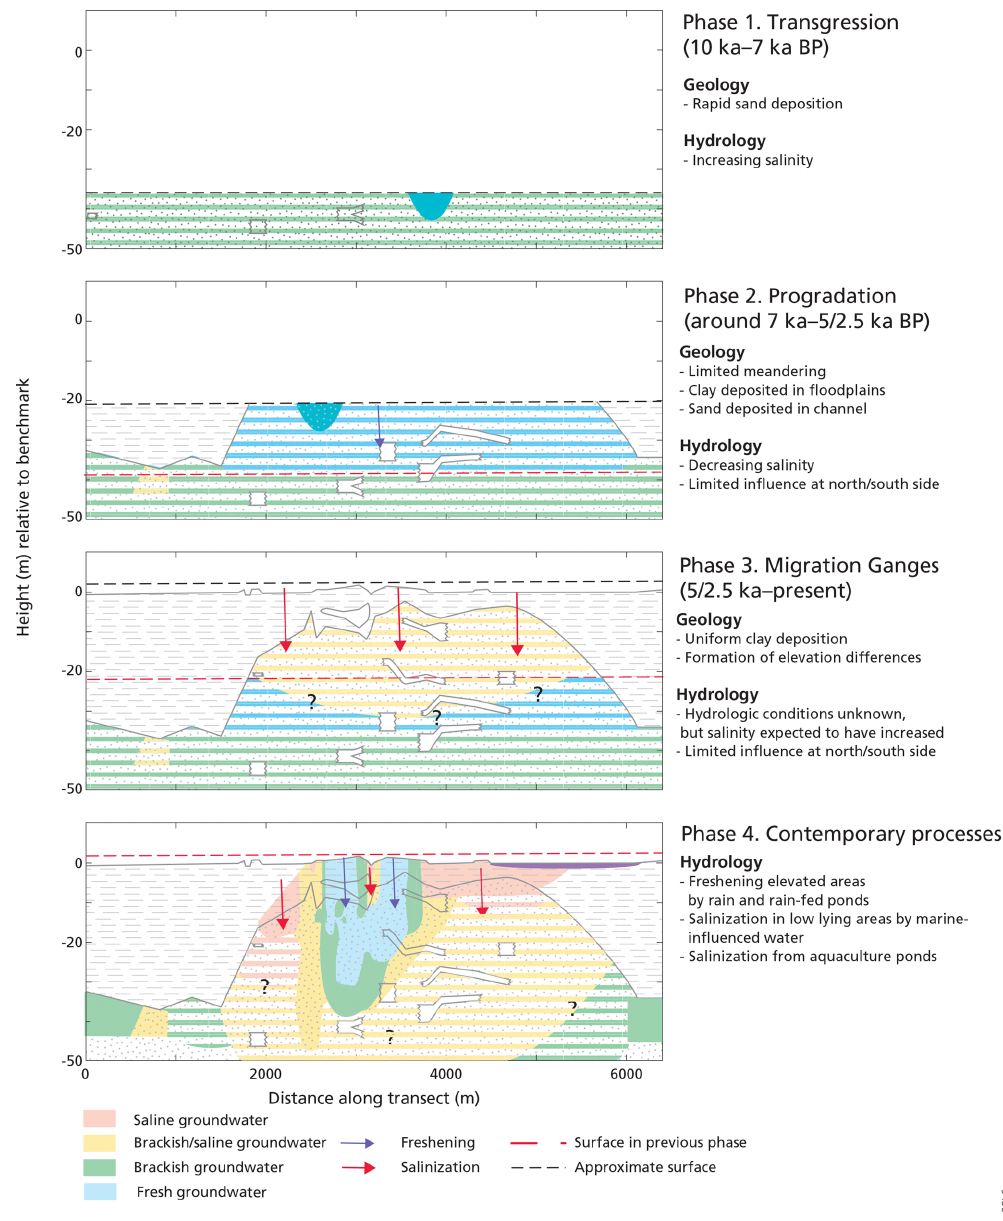
Figure 8. Sediment build-up and associated freshening and salinization processes in the study